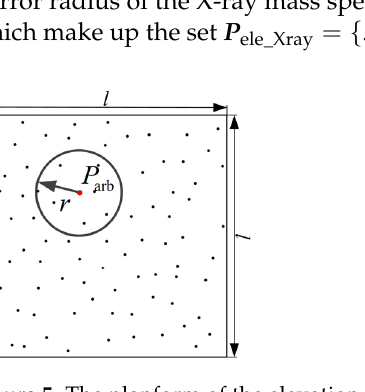
P in a grid. Figure 5. The planform of the elevation points near point Figure 5. The planform of the elevation points near point P arb in a grid. arb The N arb elevation points are used to fit the plane S det as stated in Section 2.1.1, and The N elevation points are used to fit the plane S as stated in Section 2.1.1, arb det the distance l k from the points P ele_Xray_k ( x k , y k , z k ) , ( k = 1, 2, . . . , N arb ) in the set P ele_Xray l from the points and the distance k to S det is calculated by Equation (7). The FEI σ is defined by the standard deviation of l k ( k = 1, 2, . . . , N arb